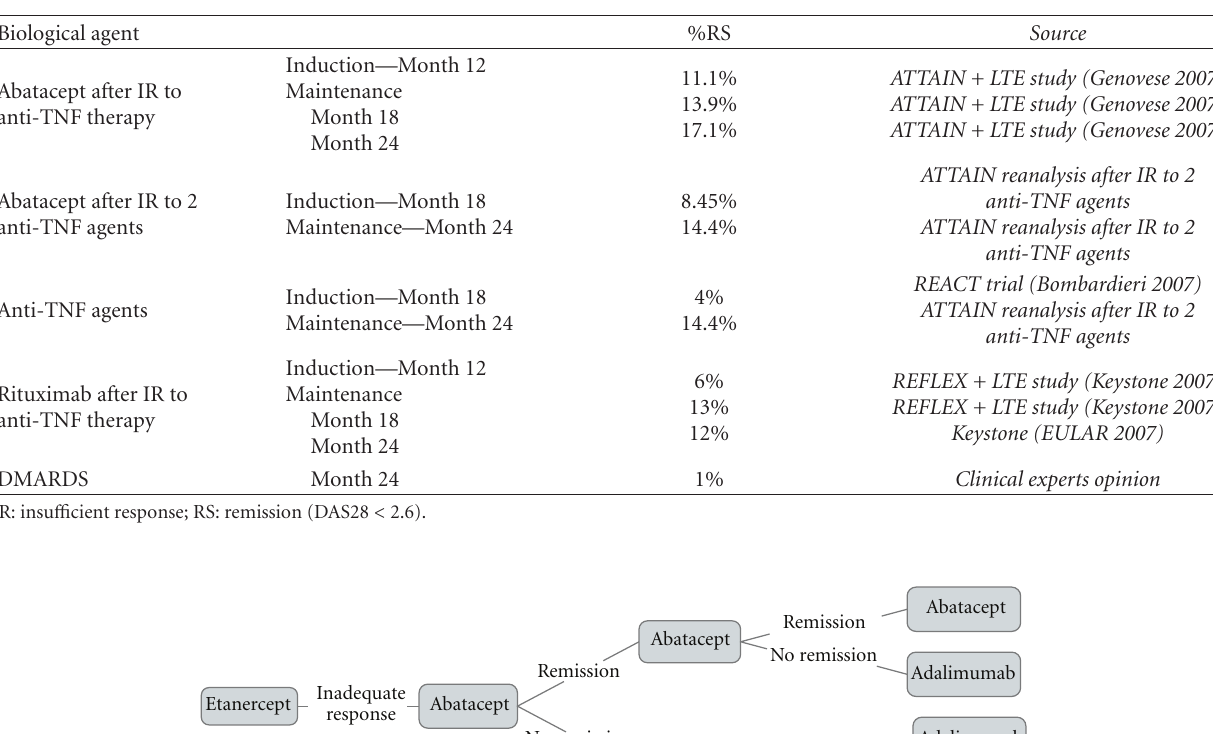
Table 4: Summary of e ff ectiveness probabilities (percentage of patients achieving RS).